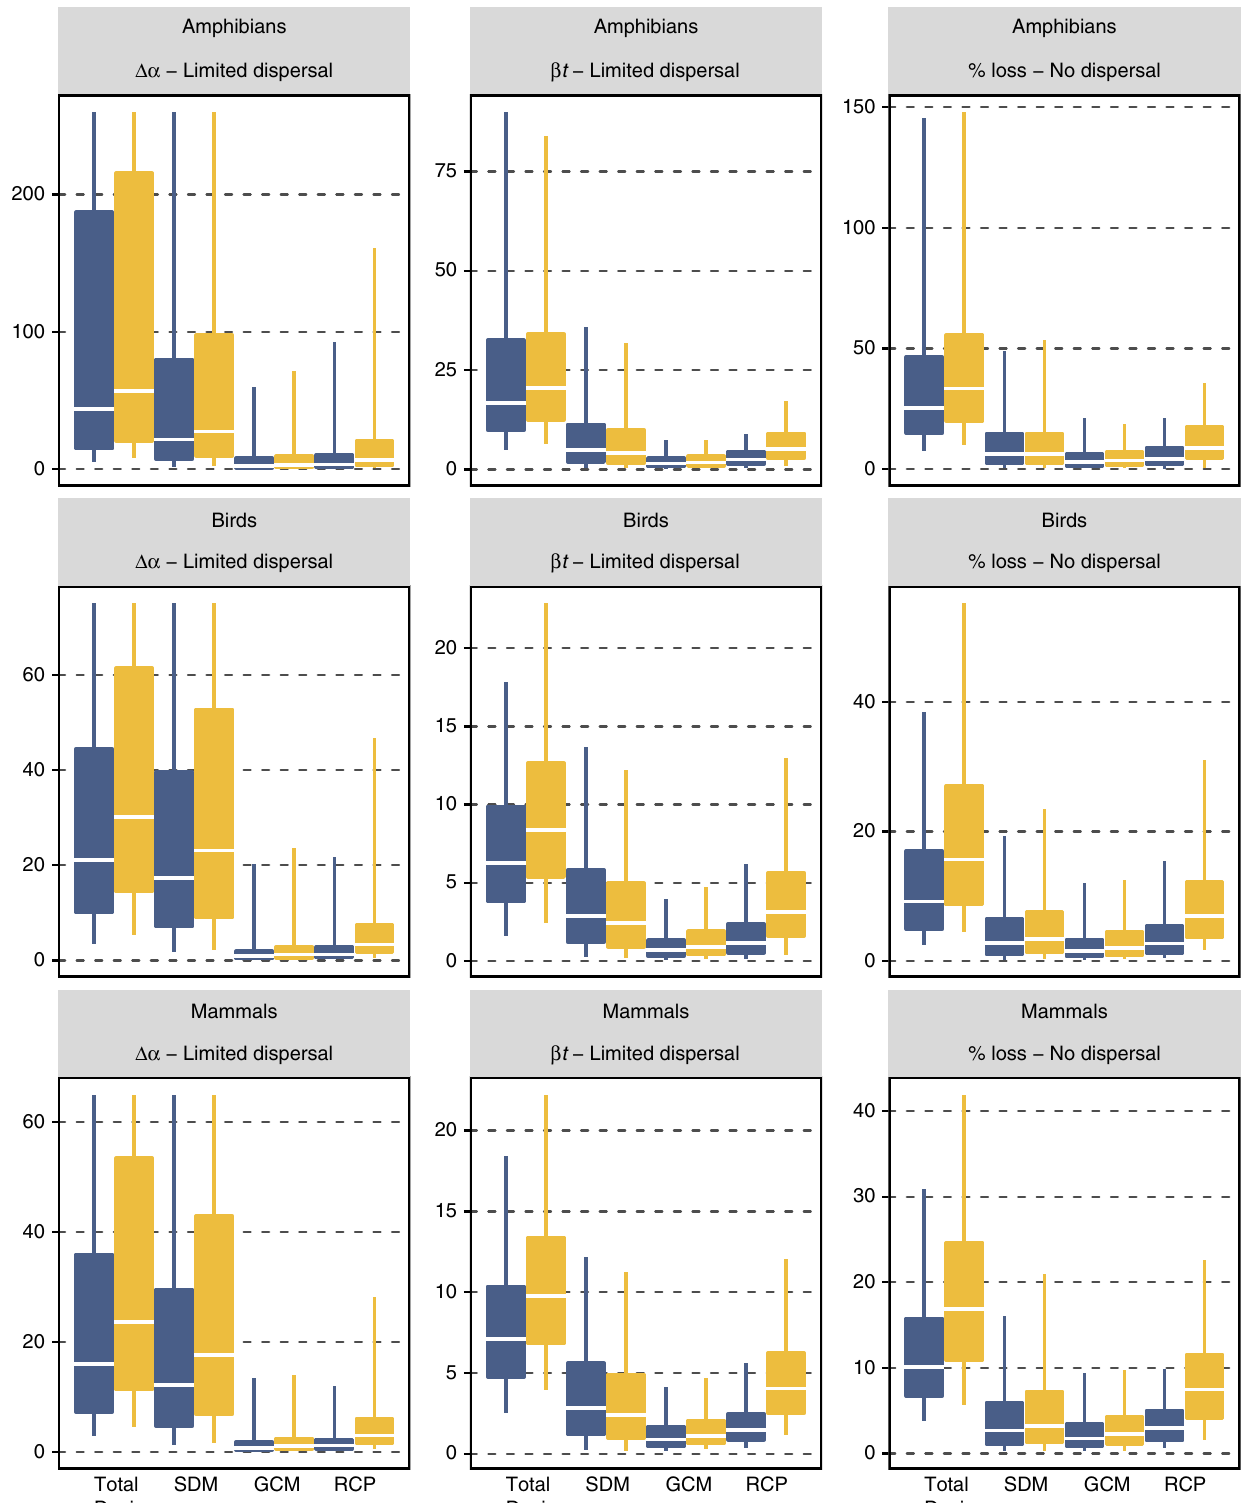
Fig. 3 Absolute in fl uence of the different sources of variation on pixel-based sensitivity metrics. The plot represents the absolute in fl uence of the choice of species distribution models (SDMs), global circulation models (GCMs) and representative concentration pathways (RCPs) on the change in α -diversity per-pixel ( Δα ), temporal species turnover ( β t) and percentage of species loss per pixel (% loss). The deviance was calculated across all pixels together by means of a nested ANOVA and the partitioning is represented by the absolute deviance to show the difference in deviance between metrics. Dark and light grey correspond to the horizon 2041 – 2060 and 2061 – 2080, respectively. Total deviance bar shows the total deviance that was explained by all components in the ANOVA. The central line of each box correspond to the median, the bounds of box represent the 25 and 75% quantiles, and the whiskers represent the quantiles 0.05 and